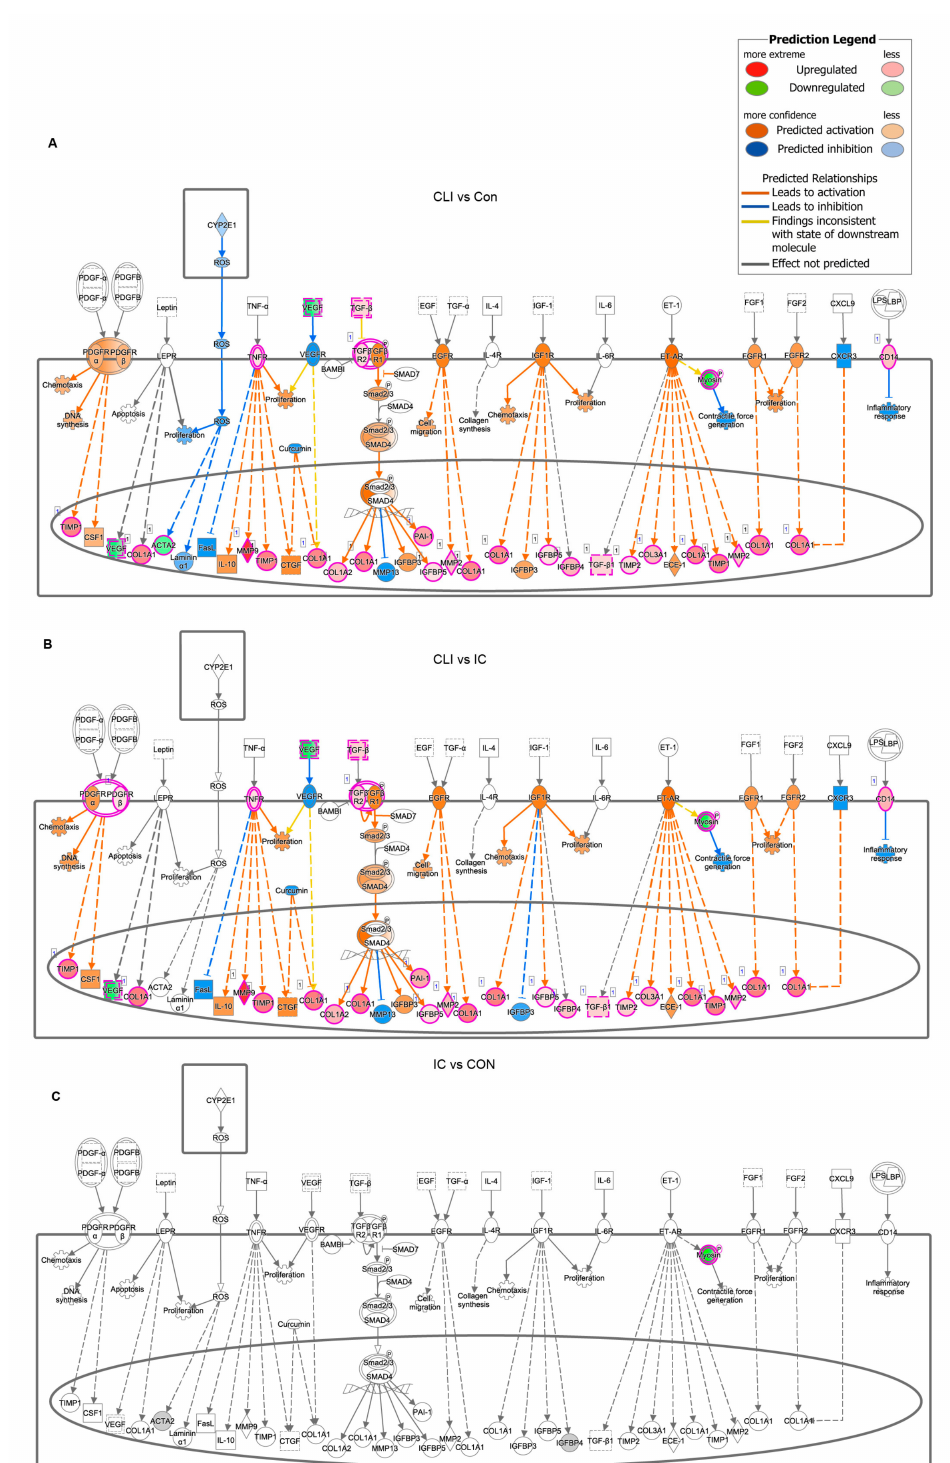
Figure 4. Network overview of modular expression patterns of fibrosis pathway. ( A ) CLI vs. Con; ( B ) CLI vs. IC; ( C ) IC vs Con. Ingenuity Pathway Analysis of the di ff erentially regulated genes when CLI vs. control and CLI vs IC. The network is displayed graphically as nodes (genes / gene products) and edges (biological relationship between nodes). The node color intensity indicates the fold change expression of genes, with red representing activation, green representing down-regulation of genes, orange representing prediction activation, and blue representing prediction inhibition; the lines indicate the type of